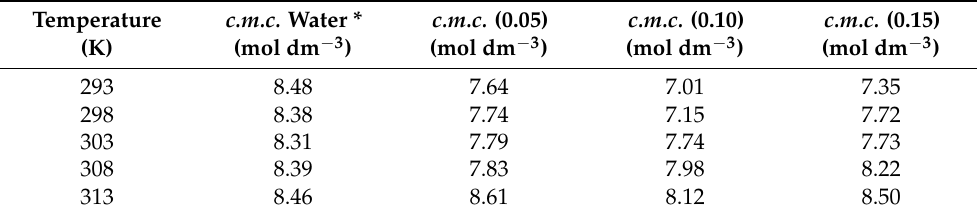
Table 1. Values of c.m.c. of SDS in pure water and water–propane-1,2-diol mixtures where mass fraction of glycol component equals 0.05, 0.10 and 0.15.